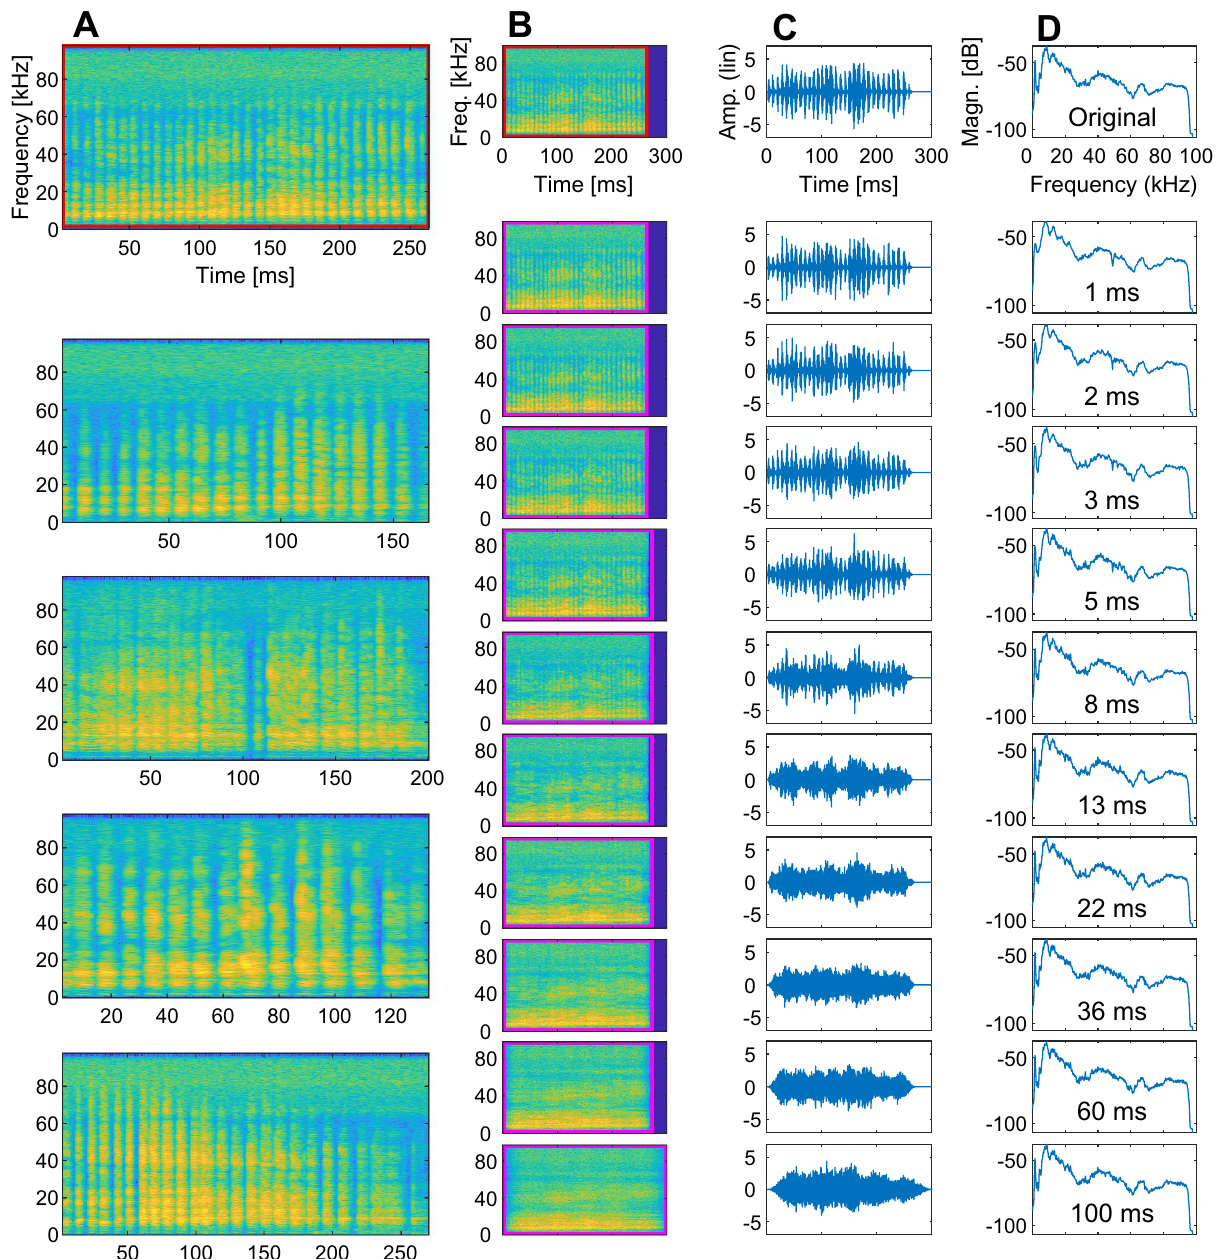
Figure 1. Original and phase-randomized aggression calls. ( A ) The spectrograms of the five original aggression calls used in this study illustrate strong amplitude modulations (FFT size 1024 samples, overlap 1020 samples). (B ) The spectrograms of one of the original calls (highlighted in red) and its ten phase-randomized versions (highlighted in magenta) exemplify the effect of increasing randomization-window lengths ranging from 1 to 100 ms (top to bottom, cf panel ( D ). ( C ) The waveforms of the signals in ( B ) illustrate the decrease in envelope amplitude fluctuations with increasing randomization-window length (top to bottom). All calls were normalised to RMS amplitude. ( D ) The magnitude spectra of the signals in ( B ) reveal no strong effect of the phase- randomization. Numbers depict randomization-window